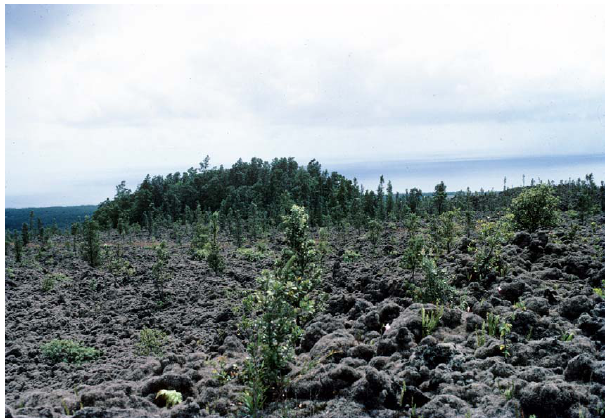
Fig. 2. The same Kam ā `ili `a` ā flow fourteen years later with cohort of Metrosideros saplings (photo by D. Mueller-Dombois, 1985).